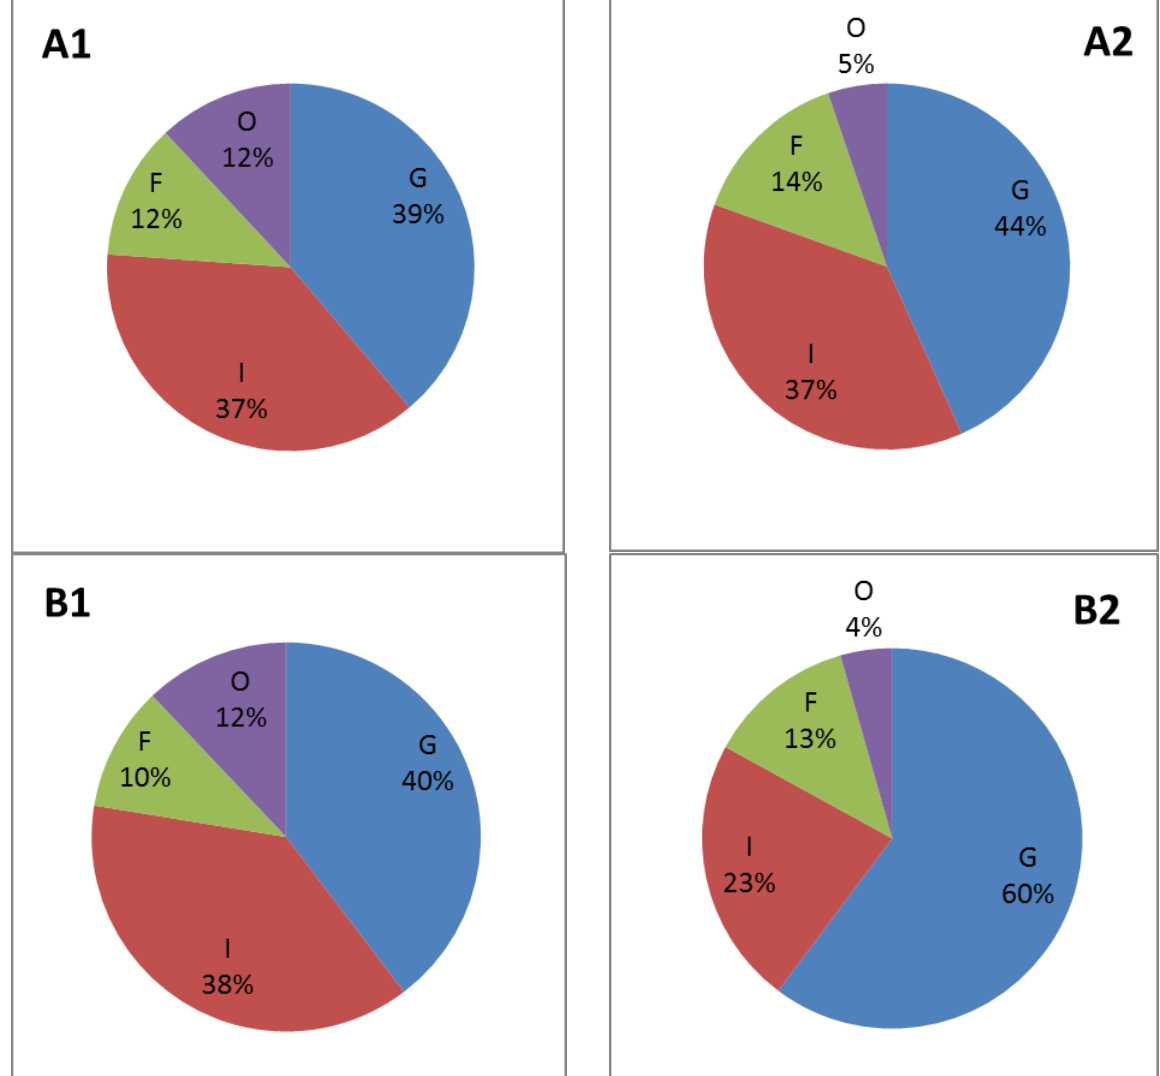
ISSN 2412-1908; http://journal.asu.ru/index.php/biol/